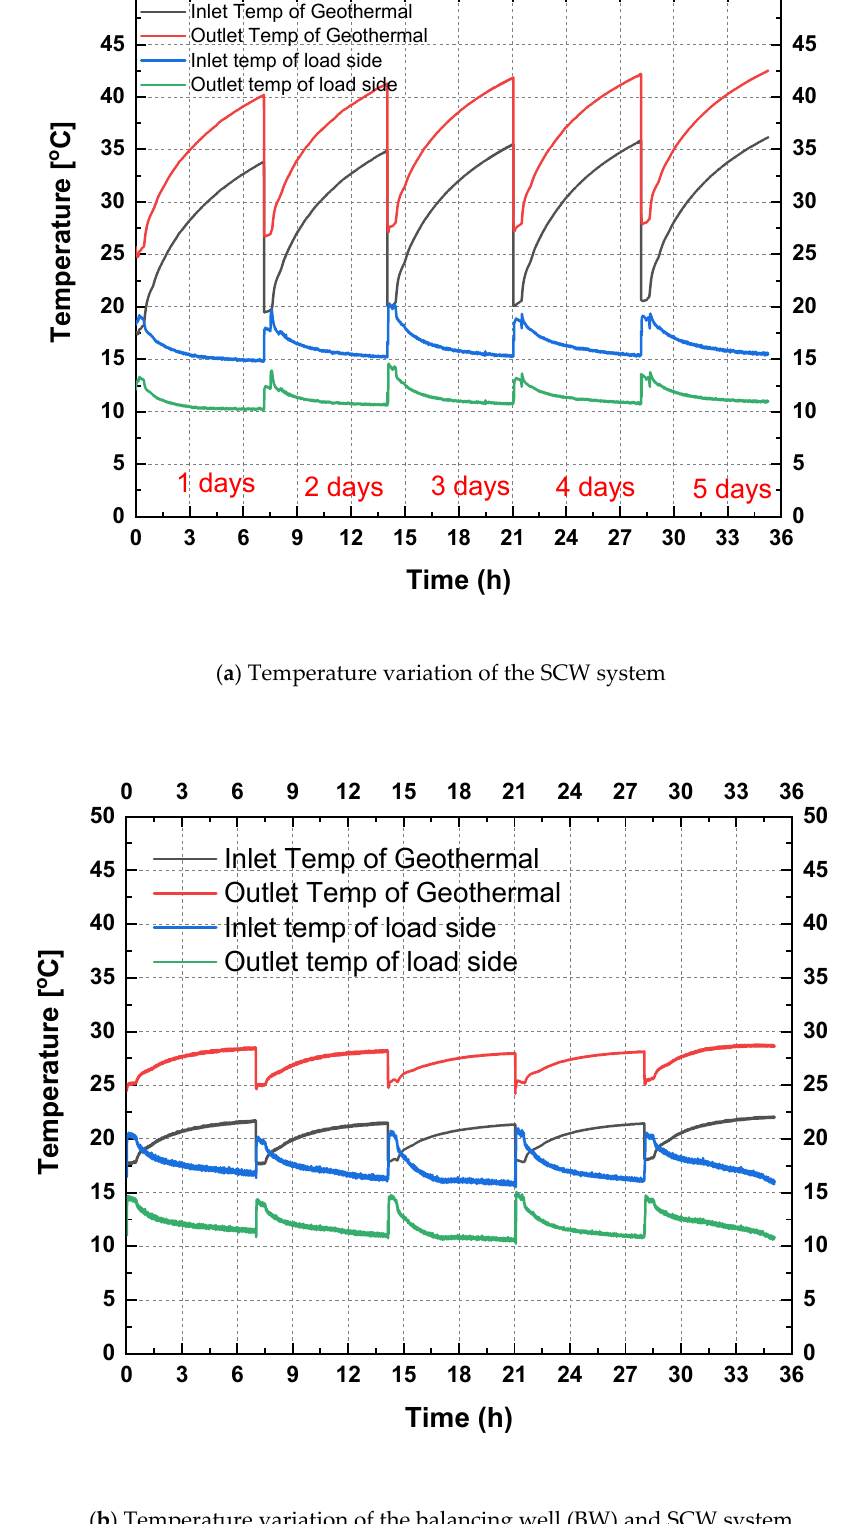
Figure 3. Temperature variation characteristics of the SCW and BW cross-mixing ground heat exchanger system during cooling operation.